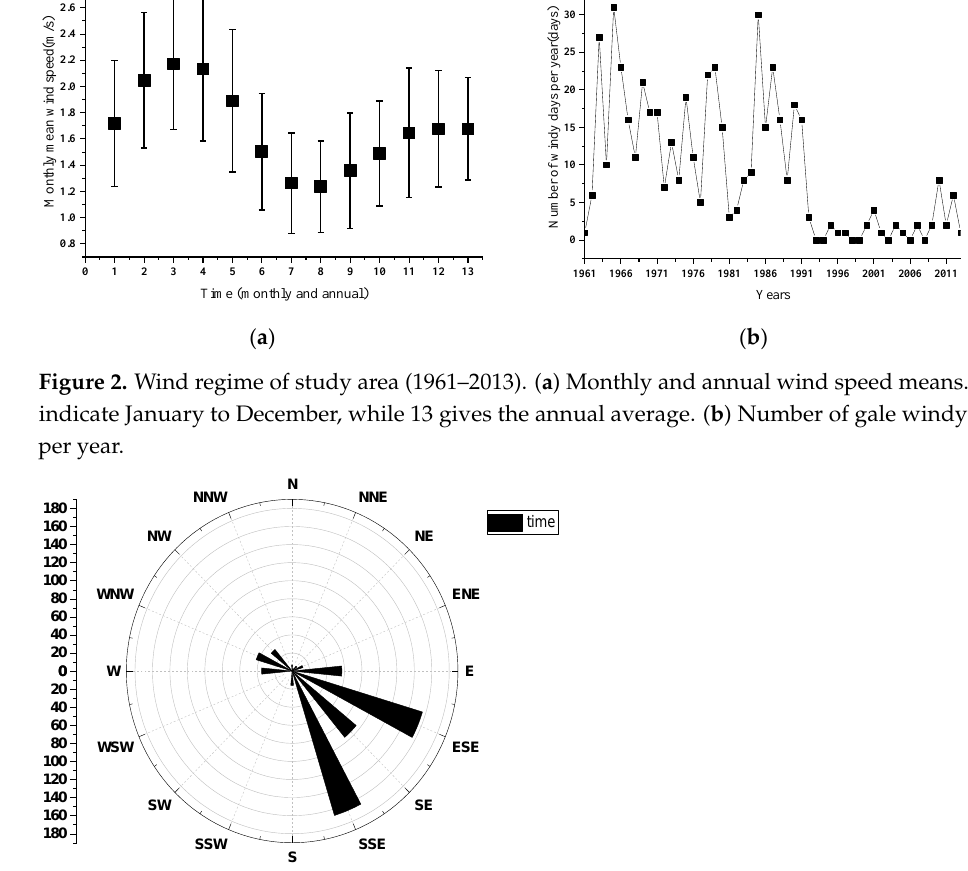
Figure 3. Wind rose diagram choosing monthly maximum frequency of wind direction (1961 – 2013).